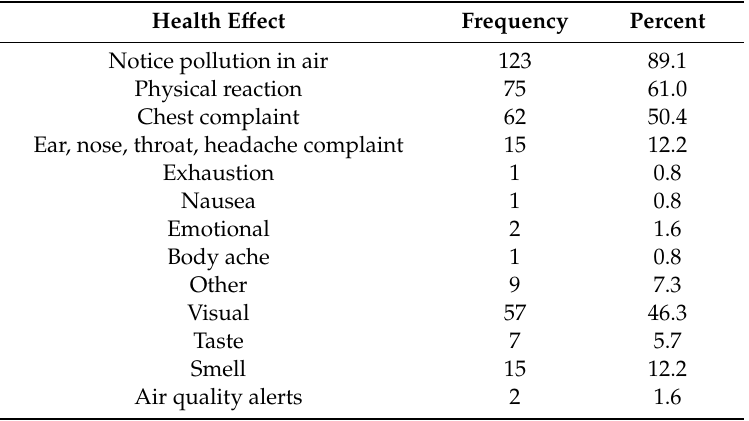
Table 3. Air pollution awareness and